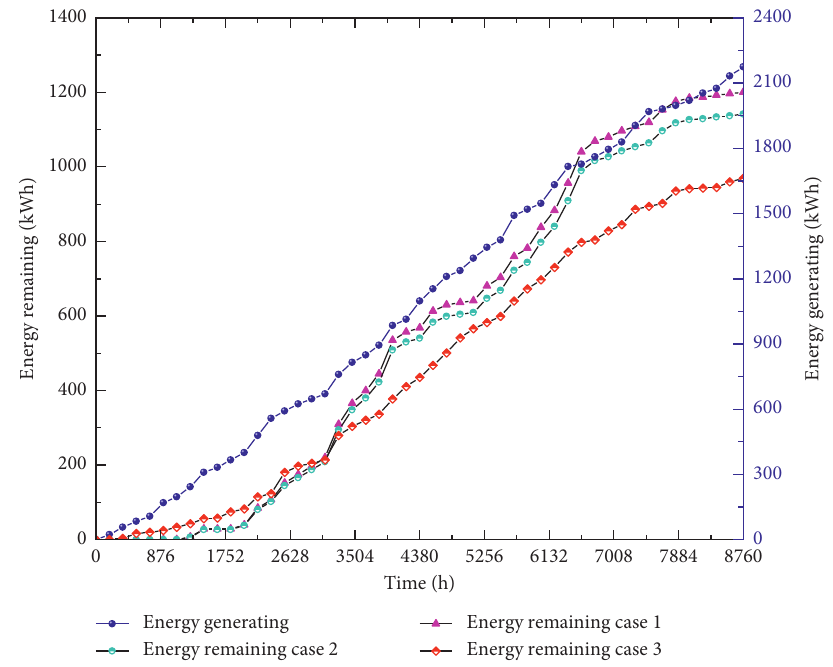
Figure 3: The simulation results of PVAC of three cases. Table 10: Results of LCC analysis of three cases.